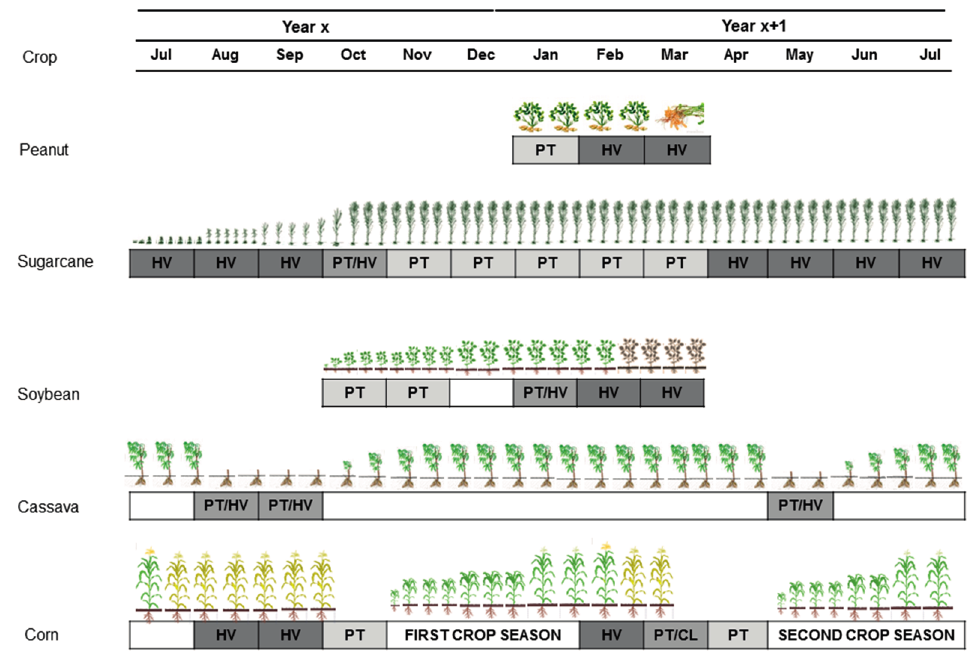
Figure 2. Crop calendar of the main crops of the Assis microregion: peanut, sugarcane, cassava, corn and soybean. PT (light grey): planting; HV (dark grey): harvesting; CL (light grey): clearing. In white: crops keep green during the period. Note that field work was done in the first half of